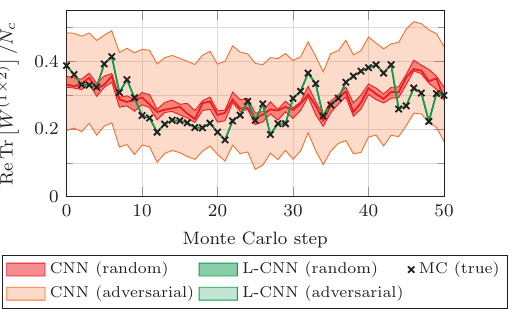
Figure 2. Scatter plots of our best L-CNN and baseline CNN models according to validation MSE on 8 8 lattices. True values of the Wilson loop are plotted against the predictions of the L-CNN model · (green dots) and the baseline CNN (black crosses). High accuracy is achieved when all points are Figure 3. Uncertainty in predictions due to broken gauge symmetry in L-CNNs (green bands) and distributed close to the 45 ◦ line. The MSE is stated in the upper left corner of each panel. We observe baseline CNNs (red bands) on 8 8 test data for the 1 2 loop regression problem. The true values (labels) that our best L-CNN models achieve low MSE for all studied loop sizes, while baseline CNNs perform · × are shown as black crosses. We use the same models as in Fig. 2. L-CNNs are invariant by construction worse at larger loop sizes. Figure adapted from [16]. and therefore only show deviations on the order of numerical precision. Baseline CNNs show much larger deviations, where the dark red band corresponds to errors due to random transformations, and the light red band shows the result of adversarial attacks. Figure from